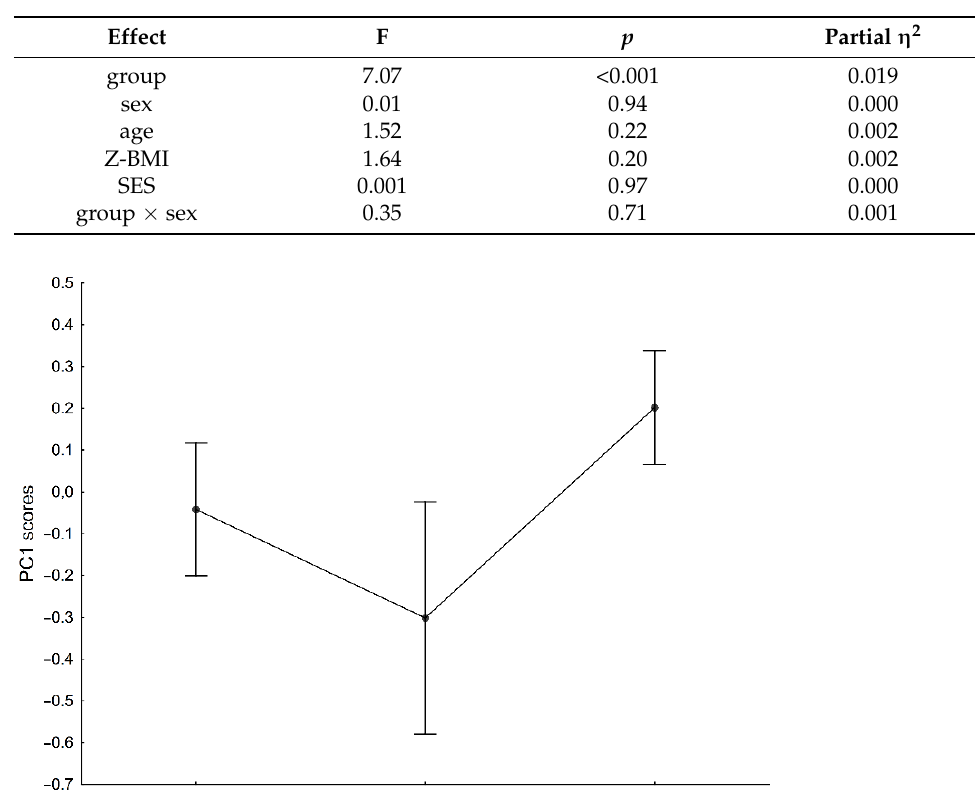
Table 3. Results for ANCOVA, with PC1 (a proxy for relative body fat distribution) as dependent variable, and group, sex, age, Z-BMI, and SES as independent variables, as well as interaction between group factor and sex.